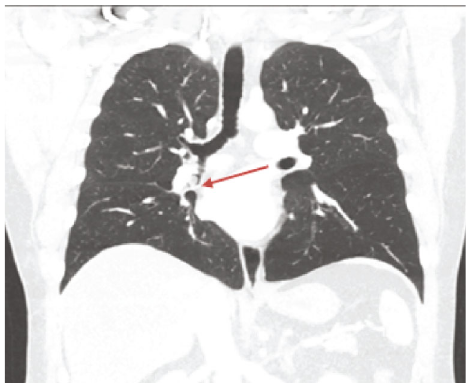
Figure 3: CT chest, coronal view: red arrow denoting another view of the exophytic soft tissue lesion.